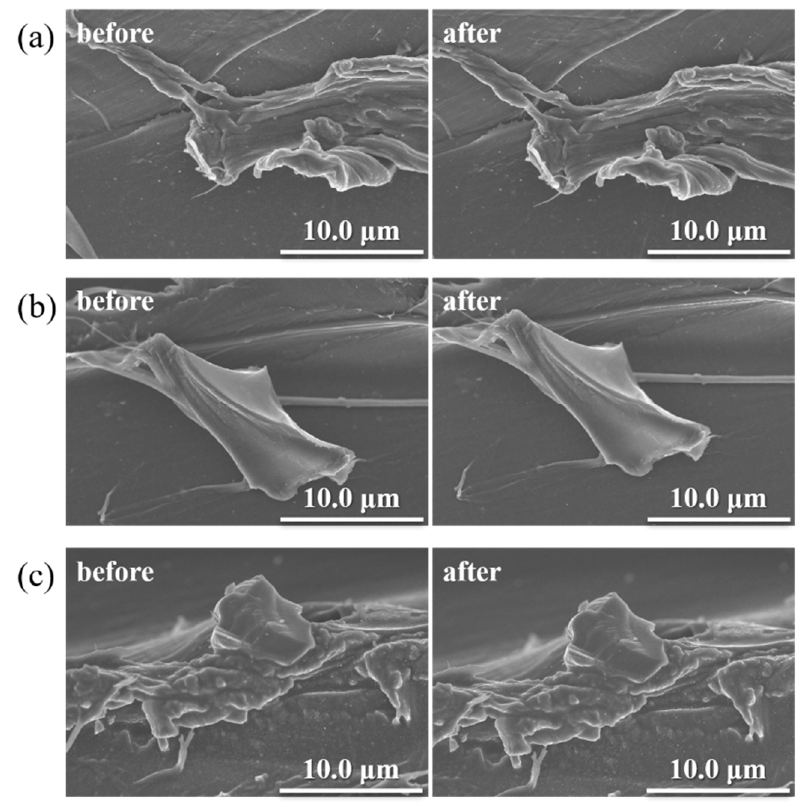
Figure 2. Low-magnification scanning electron microscope images of films of woody carbon material before and after vacuum-ultraviolet-treatments under ( a ) high P O 2 , ( b ) median P O 2 , and ( c ) low P O 2 . During the VUV treatment, the AC surface is modified by O 3 or the VUV, depending on the O 2 partial pressure. At high P O 2 , the high density of generated O 3 etched only the graphene edges, as discussed in the XPS results, which increased the surface